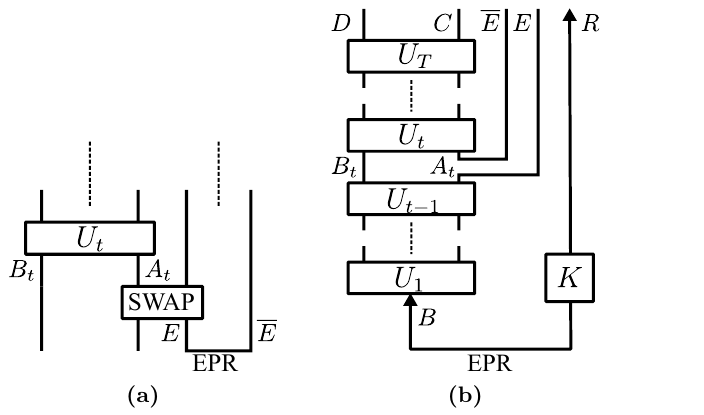
Figure 8 . A protocol for an infalling observer to access A SWAP operation between A t and E . (b) The outcome. E and A t are